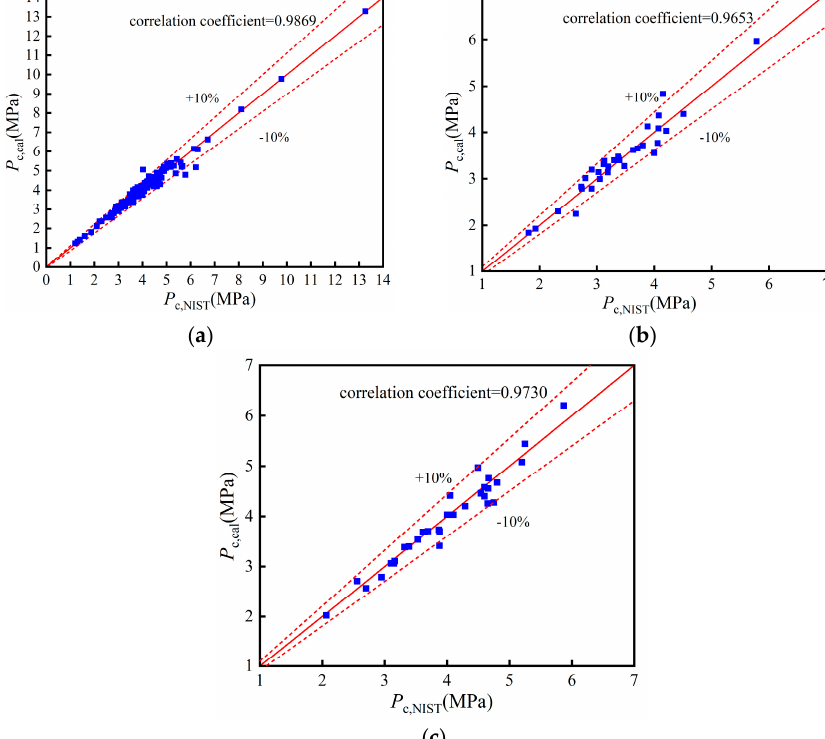
Figure A2. Comparison of p c : ( a ) Training set; ( b ) Validation set; ( c ) Test set.